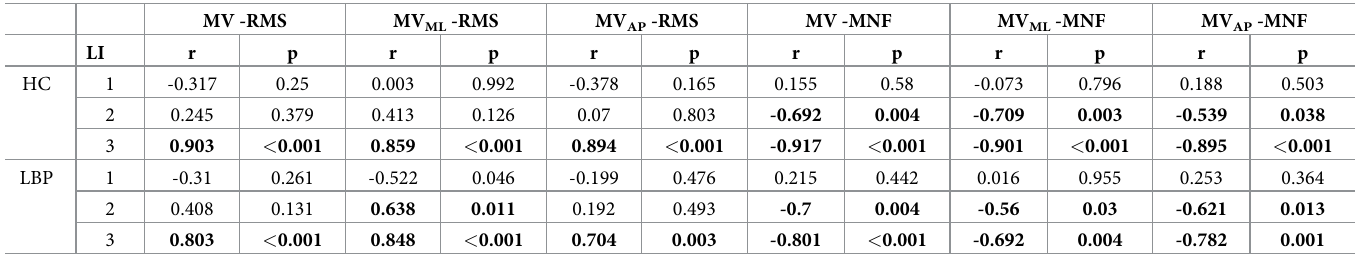
Table 3. Correlation between CoP and EMG